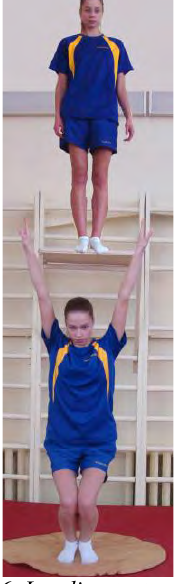
Fig. 6. Landing test with depth